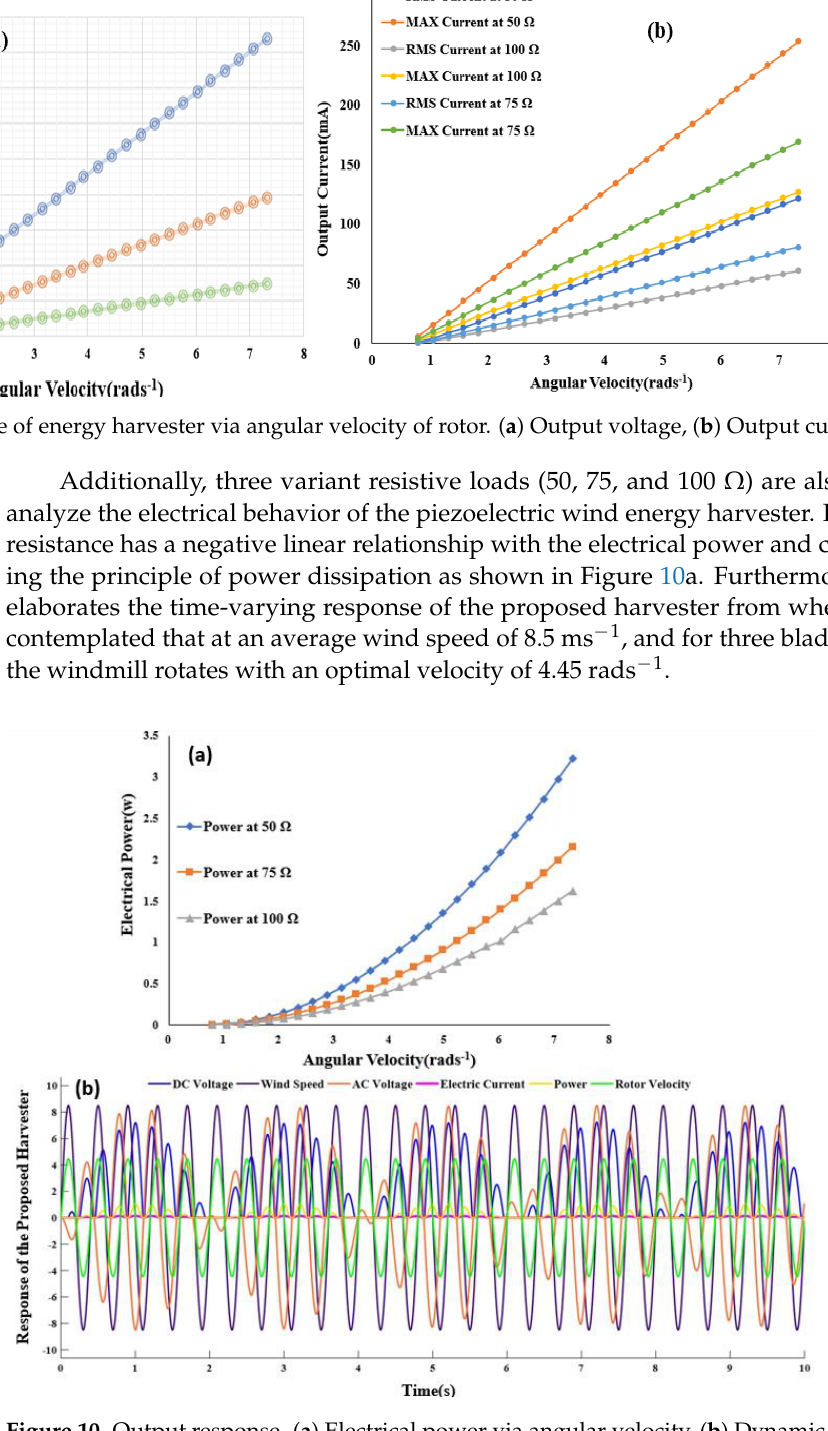
Figure 10. Output response. ( a ) Electrical power via angular velocity, ( b ) Dynamic input-output of the harvester.